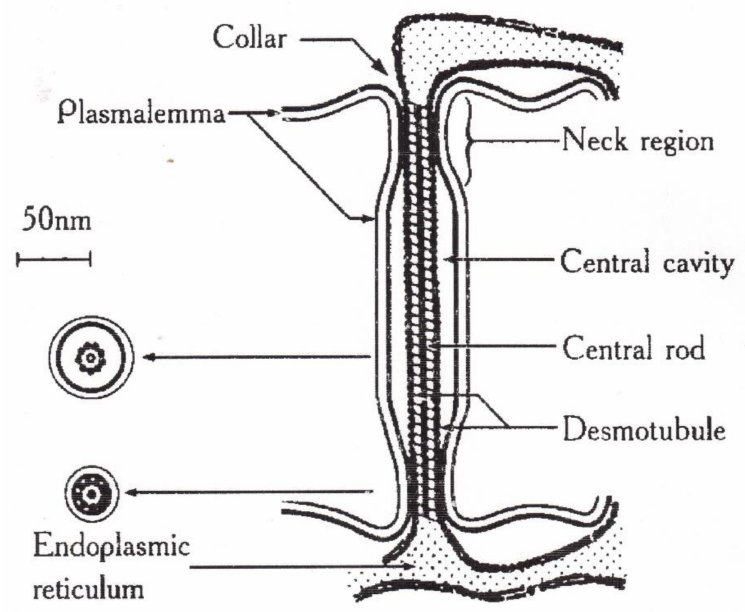
Figure 7. Schematic image of a simple plasmodesma.